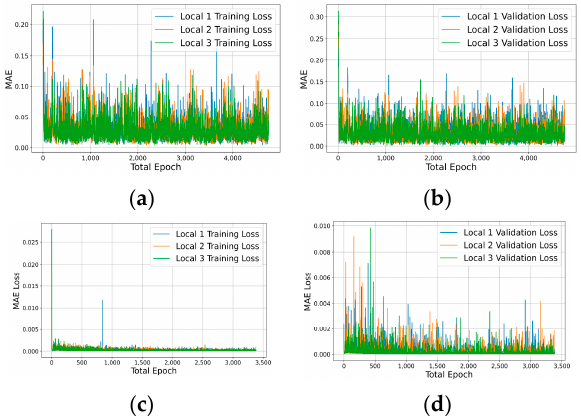
Figure 7. MAE values for FL: ( a , b ) the training and validation losses on daily updates; ( c , d ) the training and validation loss for yearly updates.